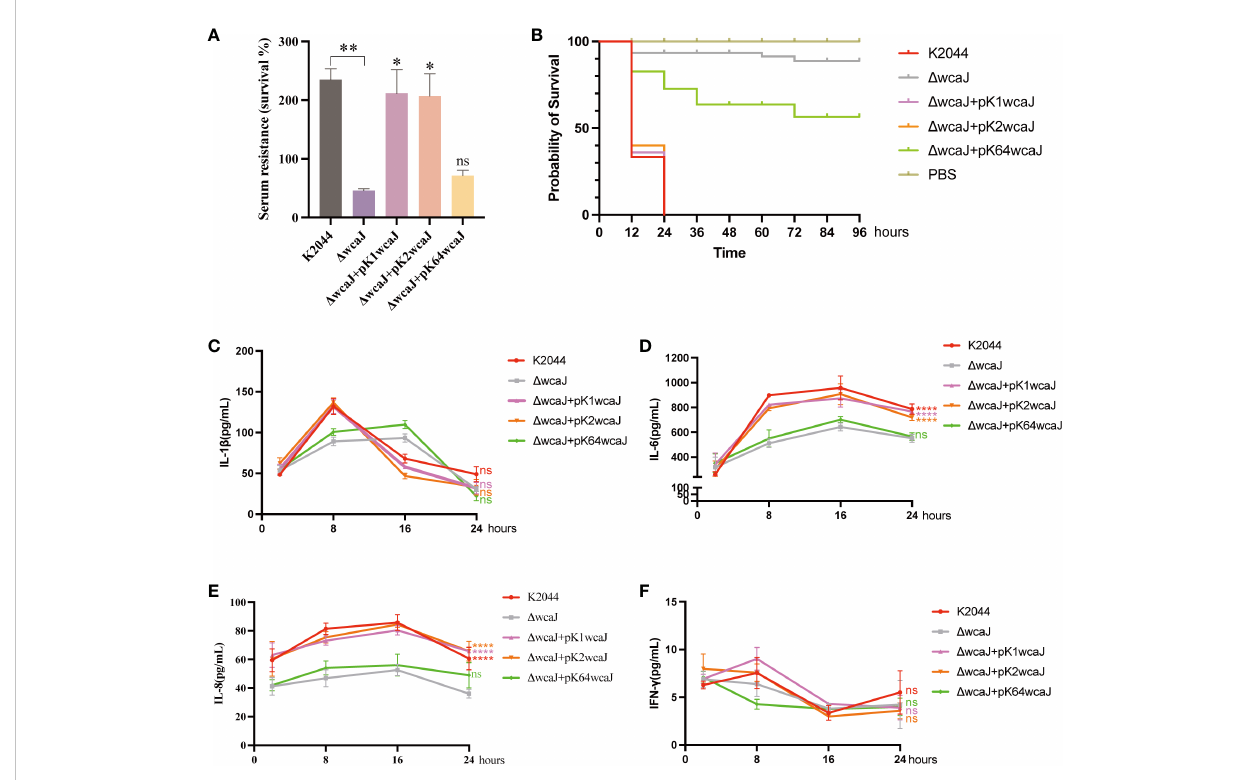
FIGURE 6 The virulence phenotype of different Klebsiella pneumoniae mutants. (A) Serum resistance of K2044, K2044 K1wcaJ , K2044 K2wcaJ , and K2044 K64wcaJ , with K2044 D wcaJ as a reference. (B) The survival curves of infected Galleria mellonella larvae; a log-rank (Mantel – Cox) test was used to analyze the survival curves. (C-F) Production of the in fl ammatory cytokines (C) IL-1 b , (D) IL-6, (E) IL-8, and (F) IFN- g was measured by ELISA at 2, 8, 16, and 24 h. The K2044 D wcaJ mutant was analyzed as negative control, and two-way ANOVA tests were performed. Data are presented in the form mean ± SEM. ****P < 0.0001, ***P < 0.001, **P < 0.01, *P < 0.05, ns, not signi fi cant.